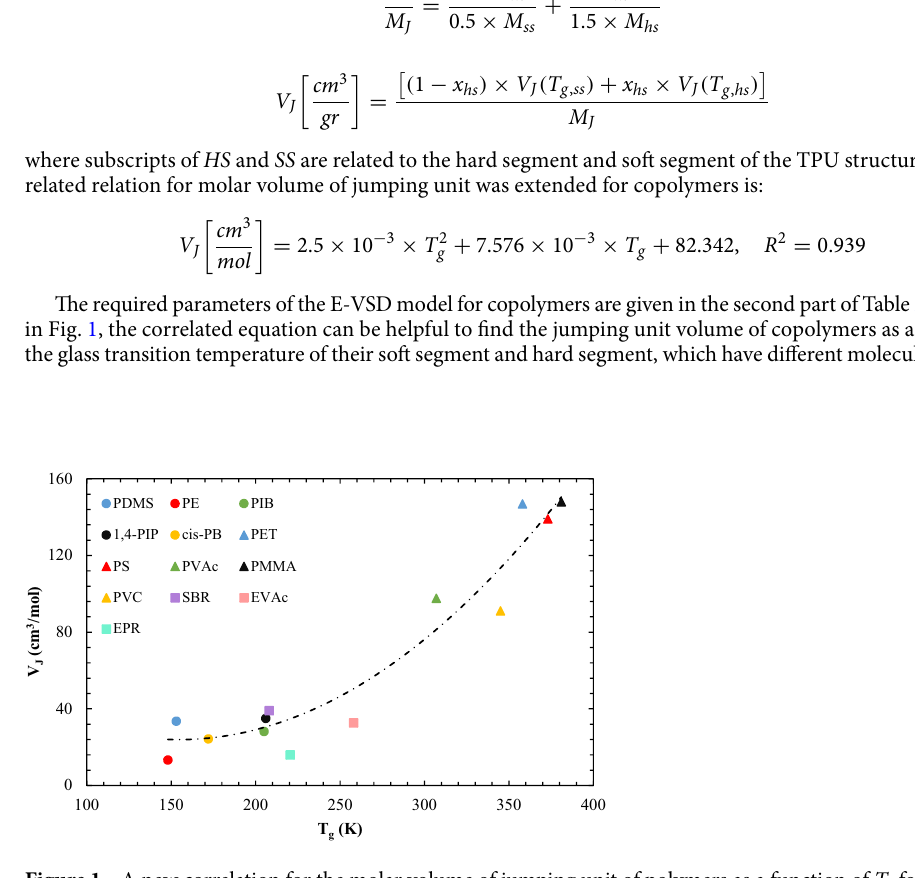
Figure 1. A new correlation for the molar volume of jumping unit of polymers as a function of T g for polymers in the range of 140 K ≤ T g ≤ 380 K 28,33